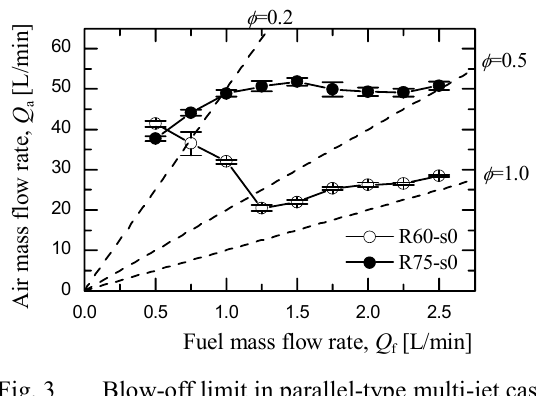
Fig. 3 Blow-off limit in parallel-type multi-jet